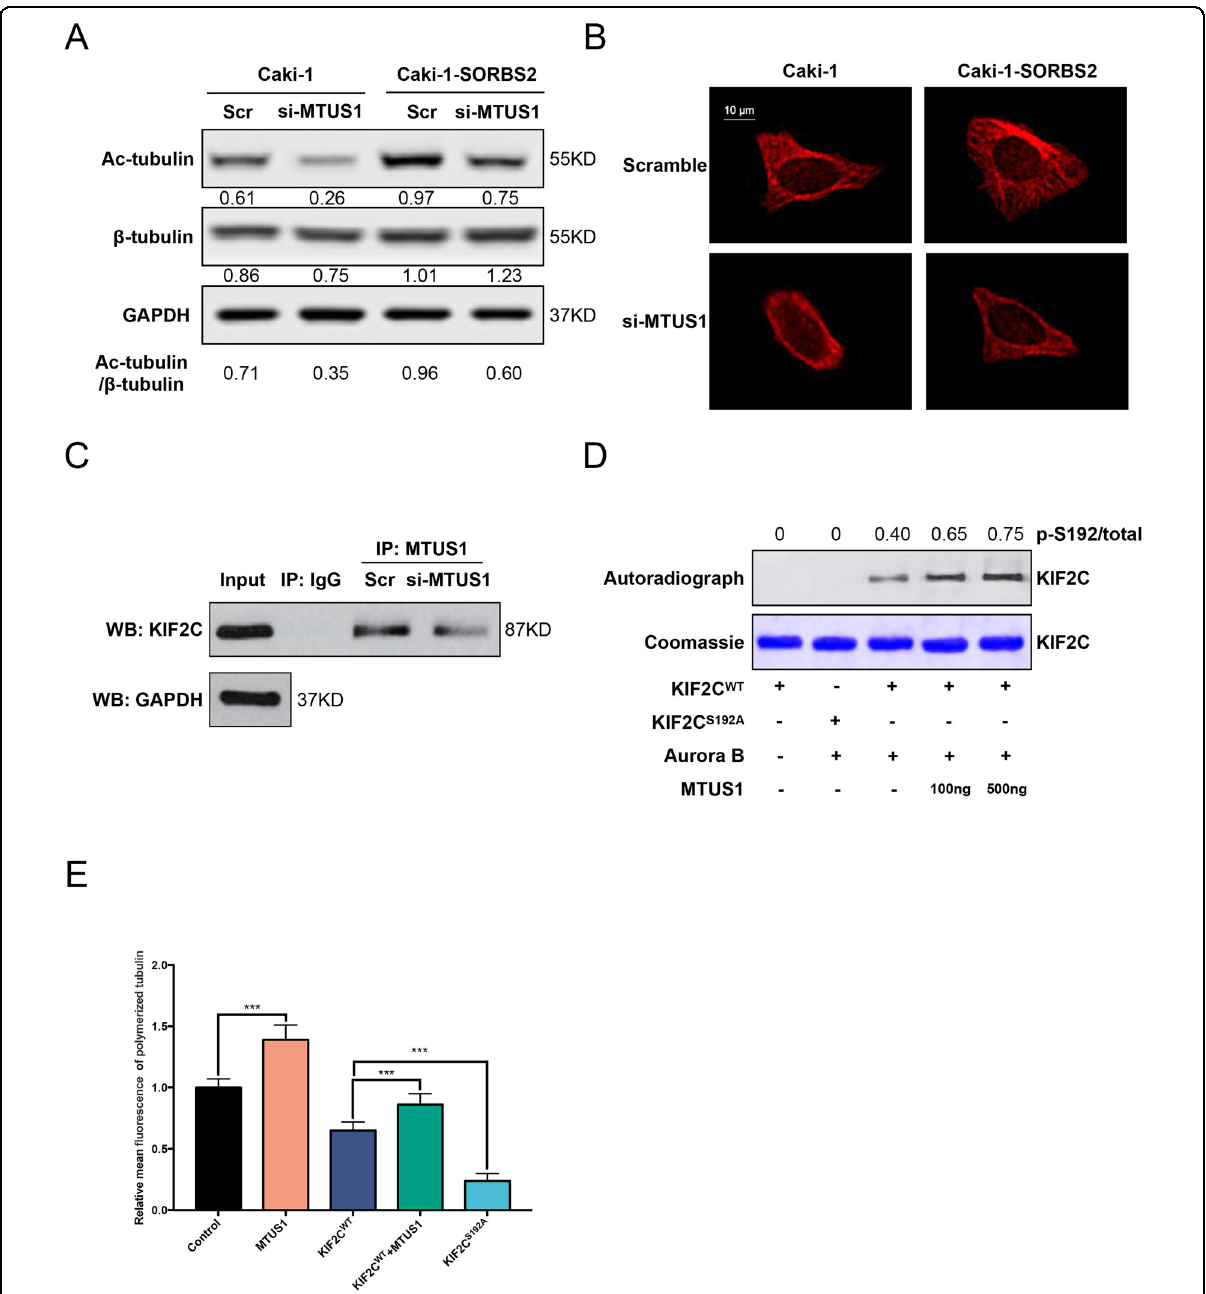
Fig. 6 MTUS1 promoted KIF2C S192 phosphorylation by Aurora B to regulate microtubule dynamics. A Western blot analysis of